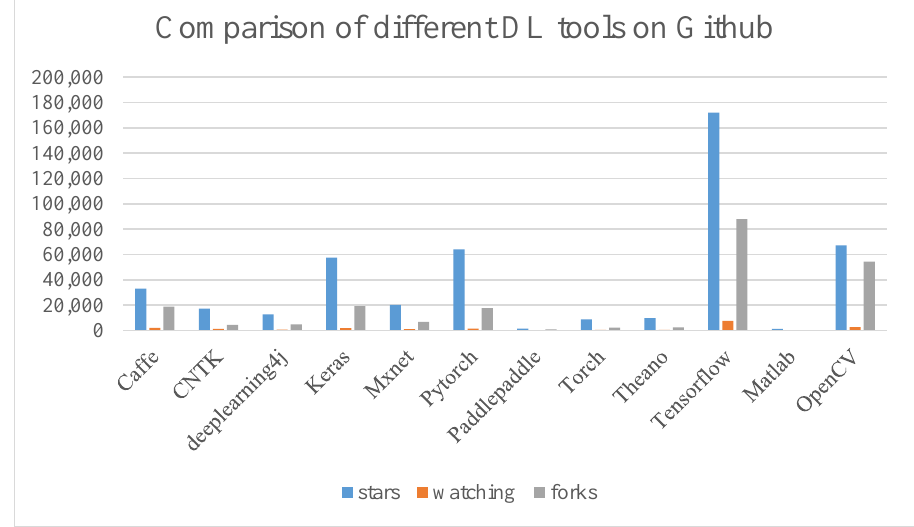
Figure 8. Comparison of different deep learning tools on GitHub.